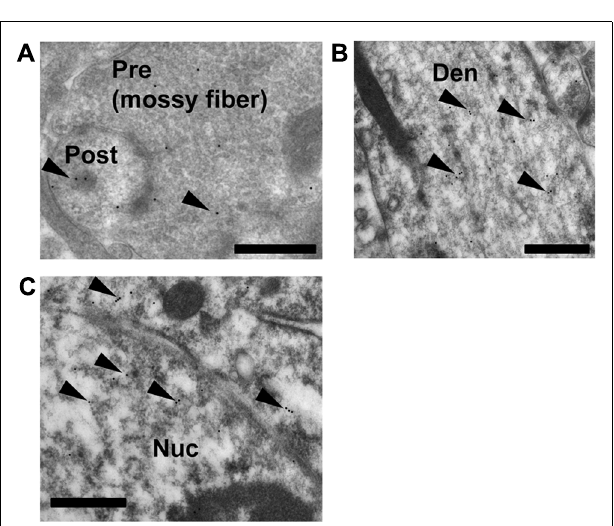
FIGURE 4 | Suppression effects by kinase inhibitors on CORT-induced changes in the density of thorns. (A) A 1 h treatment in ACSF without drugs (Control), with 1 μ M CORT (CORT), with 1 μ M CORT and 20 μ M PD98059 (MAPK inhibitor; CORT + PD), with 1 μ M CORT and 10 μ M H-89 (PKA inhibitor; CORT + H89), with 1 μ M CORT and 10 μ M chelerythrine (PKC inhibitor; CORT + Chel), and with 1 μ M CORT and 10 μ M GSK-3 β InhibitorVIII (CORT + I8). (B) No effect of kinase inhibitors alone on the density of thorns